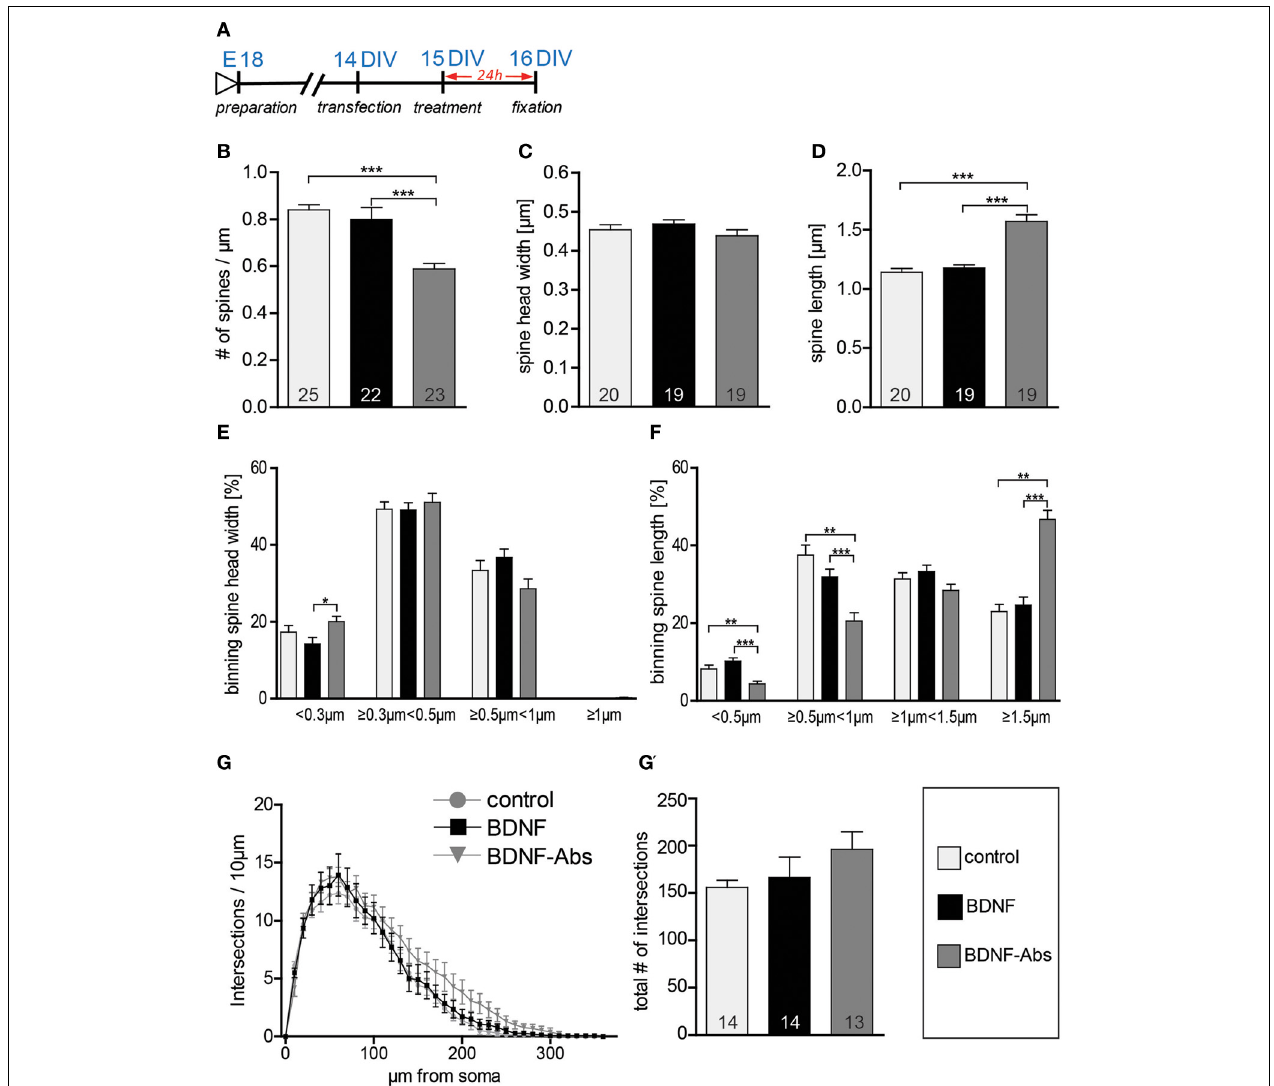
FIGURE 2 | (A) Experimental timeline. DIV16 hippocampal neurons were treated for 24h before fixation (B) Graphs comparing dendritic spine density between control, BDNF and BDNF-antibodies (BDNF-Abs) treated DIV16 hippocampal neurons. (C) Histogram comparing the spine head width between hippocampal neurons upon BSA (control), BDNF or BDNF antibodies treatment. (D) Histogram of the dendritic spine length in BSA (control), BDNF or BDNF antibodies (BDNF-Abs) treated neurons. (E) Graph showing the binning of spines according to their spine head width and comparing the proportion of spines within each category in response to a BSA (control), BDNF or BDNF antibodies (BDNF-Abs) treatment. (F) Graph